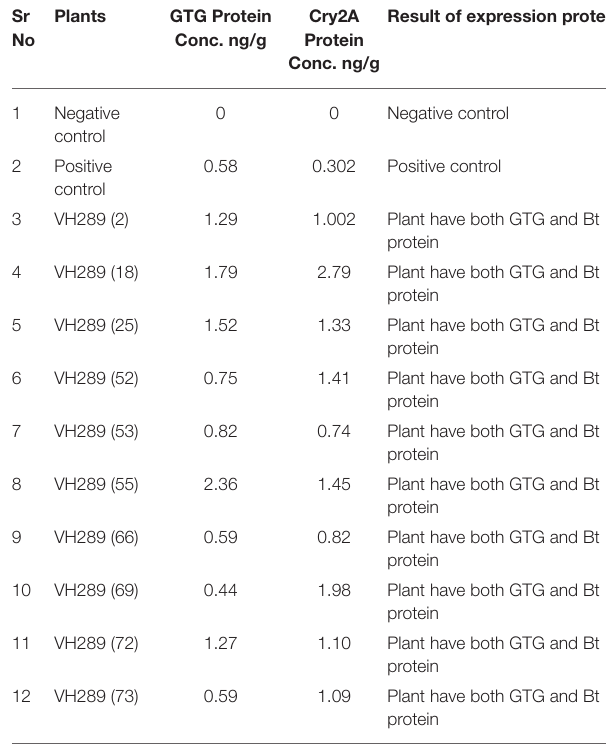
TABLE 5 | Concentration Cry2A and GTG protein of putative transgenic cotton plants (T 0